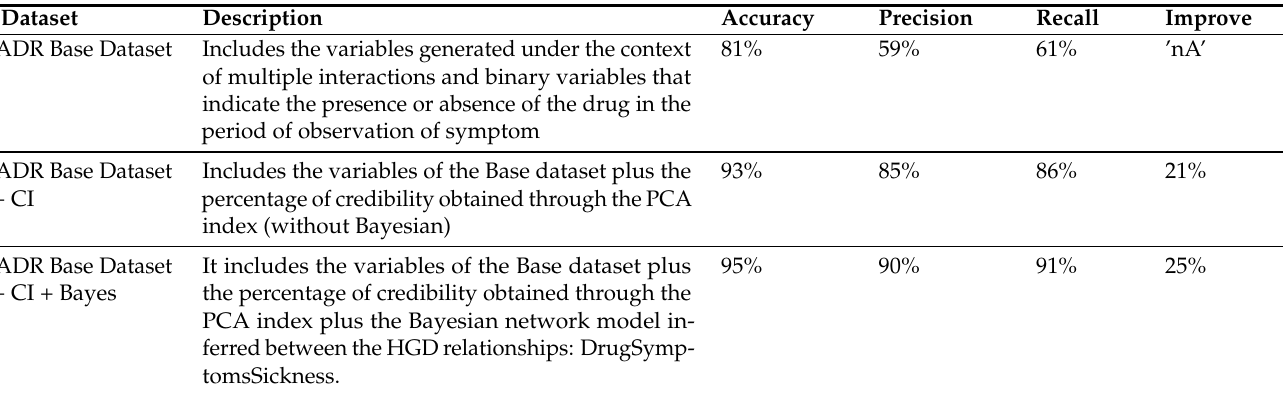
Table 3. Benchmark analysis